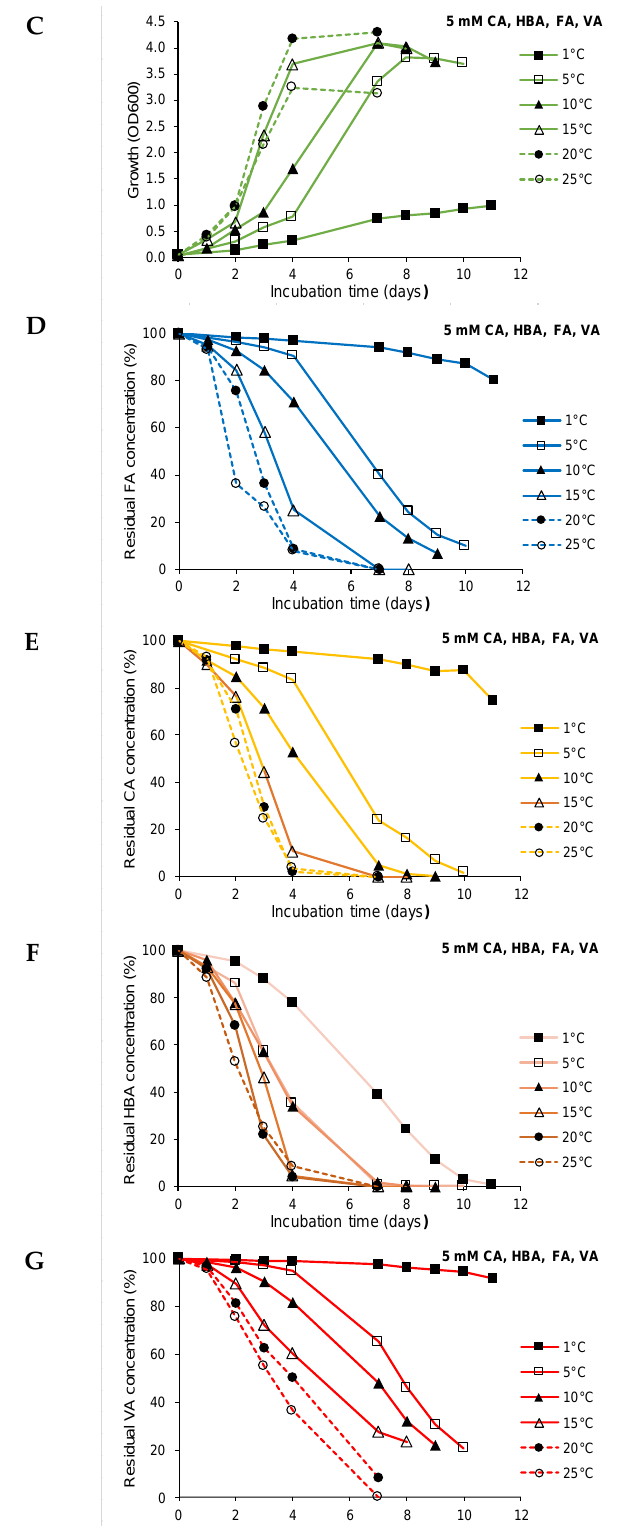
Figure 4. Effect of temperature on growth ( A ) and degradation ( B ) of 5 mM FA (100% = 5 mM; lower panel) by R. colostri DBVPG 10655. Effect of temperature on growth ( C ) and degradation ( D – G ) of a mixture of FA, CA, HBA, and VA (100% = 5 mM) by R. colostri DBVPG 10655. FA, trans -ferulic acid; CA, p -coumaric acid; HBA, 4-hydroxybenzoic acid; VA, vanillic acid (mean values of three replicates; SDs ≤ 10 – 15%).